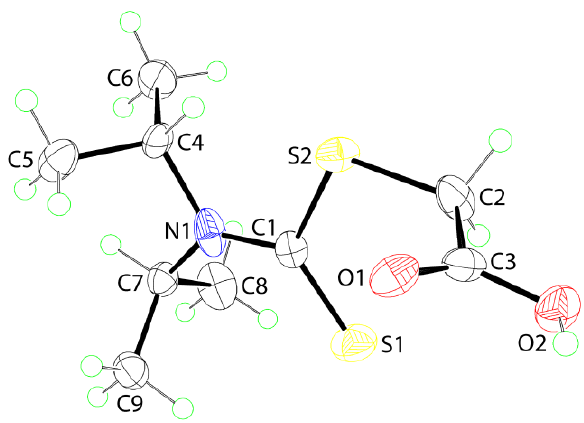
Figure 3. The molecular structure of compound 1 showing atom labeling and displacement ellipsoids at the 50% probability level. Selected geometric parameters: C1–S1 = 1.6611(18) Å , C1–S2 = 1.7834(18) Å , C2–S2 = 1.7793(19) Å , C3–O1 = 1.214(3) Å , C3–O2 = 1.314(3) Å , C1–N1 = 1.334(2) Å ; S1–C1–S2 =